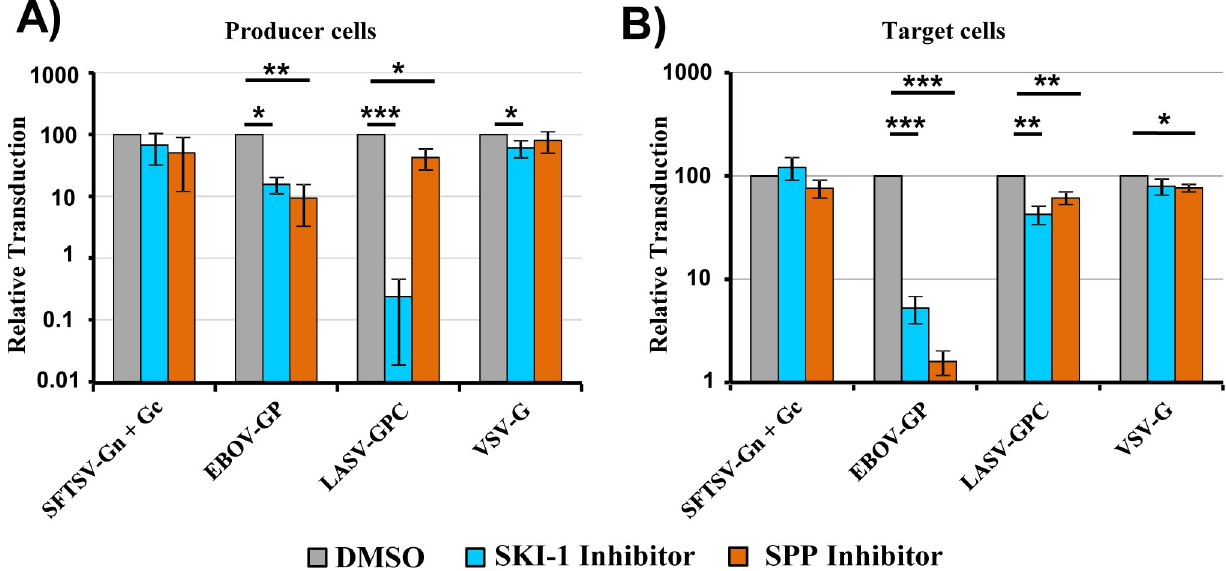
Fig 1. SKI-1 and SPP inhibitors block transduction mediated by EBOV-GP. (A) Rhabdoviral vectors encoding luciferase and pseudotyped with the indicated viral glycoproteins were produced in 293T cells in the presence of an SKI-1 inhibitor (PF429242, 30 μ M), an SPP inhibitor ((Z-LL) 2 -ketone, 100 μ M) or DMSO as a control. Protease inhibitor treatment started 6 h post transfection of the glycoprotein expression plasmids. Culture supernatants containing the rhabdoviral vectors were then used for transduction of target 293T cells. Transduction efficiency was determined by quantifying luciferase activities in cell lysates at 24 h post transduction. Transduction mediated by vectors produced in the presence of DMSO was set as 100%. (B) Rhabdoviral vectors pseudotyped with the indicated viral glycoproteins were used for transduction of target 293T cells in the presence of the indicated inhibitors or DMSO as a control. Protease inhibitor treatment was started 24 h prior to transduction with pseudotyped rhabdoviral vectors using the same inhibitor concentrations as depicted in (A). Transduction efficiency was determined by quantifying luciferase activities in cell lysates at 24 h post transduction. Transduction mediated by vectors produced in the presence of DMSO was set as 100%. The average of at least three independent experiments performed with triplicate samples is shown in panels A and B. Error bars indicate standard error of mean (SEM). Asterisks indicate a statistical significant decrease ( � = p < 0.05; �� = p < 0.01; ��� = p < 0.001) of transduction efficiency relative to the DMSO